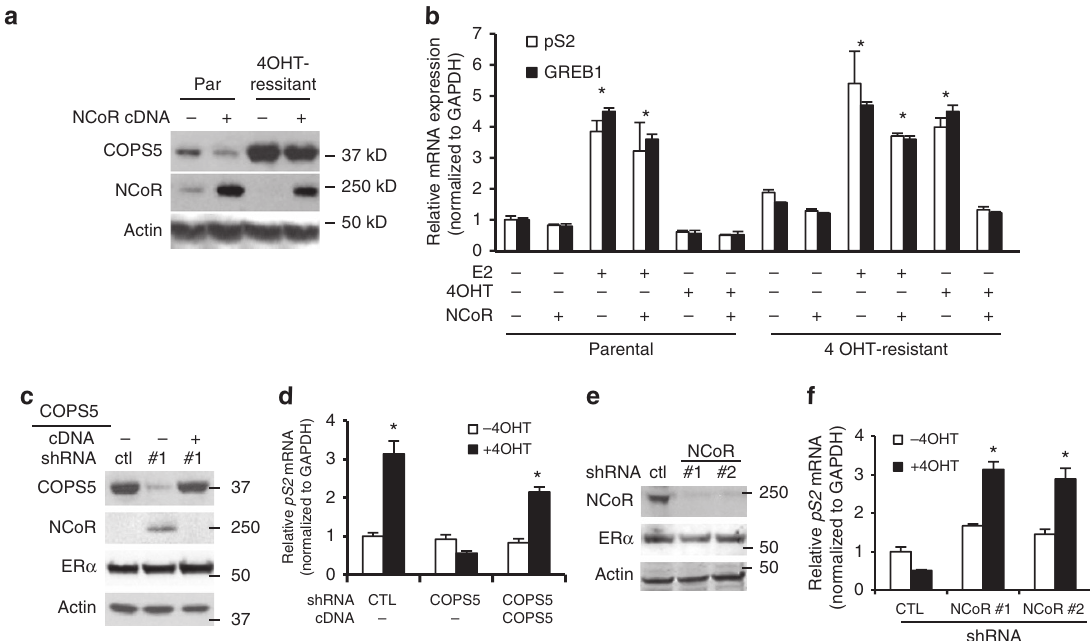
Figure 5 | COPS5-mediated 4OHT-resistance is dependent on NCoR downregulation. ( a ) Western blot analysis of COPS5 and NCoR in MCF7 cells with transient expression of COPS5 and/or NCoR. ( b ) Quantitative RT–PCR analysis of ligand-regulated ER a target gene expression in parental and 4OHT-resistant MCF7 clones with expression of NCoR. *Significant difference compared with corresponding untreated basal levels ( P o 0.01, Student’s t -test). ( c ) Western blot analysis of COPS5, NCoR and ER a expression in the 4OHT-resistant MCF7 cells stably transduced with COPS5 shRNA or rescuing COPS5 cDNA. ( d ) Quantitative RT–PCR analysis of ER a target gene pS2 in the MCF7 cell lines shown in c in response to 4OHT (500nM, 48h). *Significant difference compared with the untreated CTL sample ( P o 0.01, Student’s t -test). ( e ) Western blot analysis of NCoR and ER a expression on knockdown by stable NCoR shRNAs in parental MCF7 cells. ( f ) Quantitative RT–PCR analysis of ER a target gene pS2 in the MCF7 cell lines shown in e in response to 4OHT (500nM, 48h). *Significant difference compared with the untreated CTL sample ( P o 0.01, Student’s t -test). Data are presented as mean þ s.e.m. of three biological replicates. CTL,